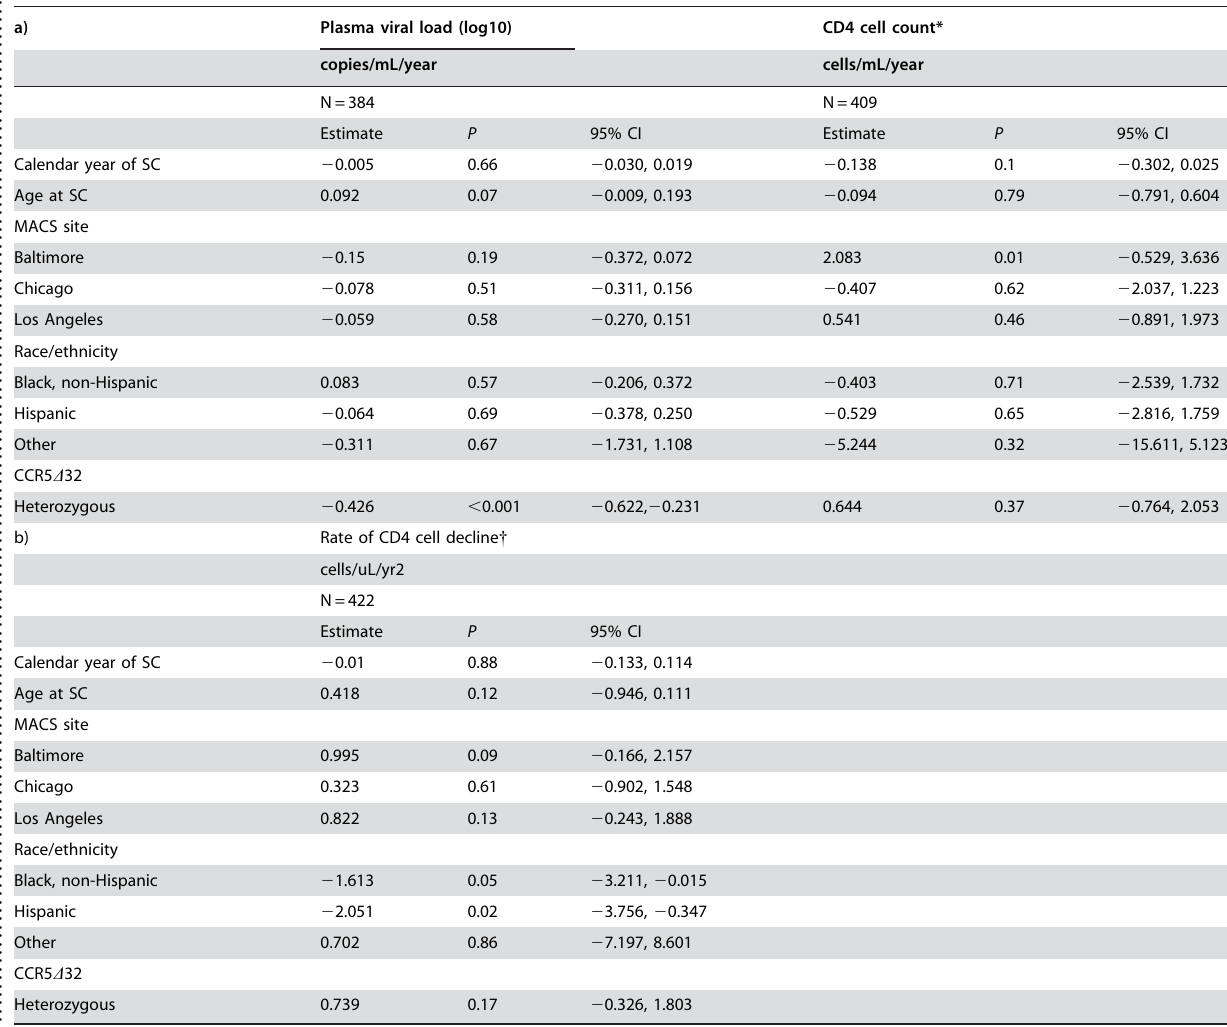
Table 3. Multivariate analyses of prognostic markers of HIV-1 disease. .. ... .... ... ... .... ... ... .... ... ... .... ... ... .... ... ... .... ... ... .... ... ... .... ... ... .... ... ... .... ... ... .... ... ... .... ... ... .... ... ... .... ... ...